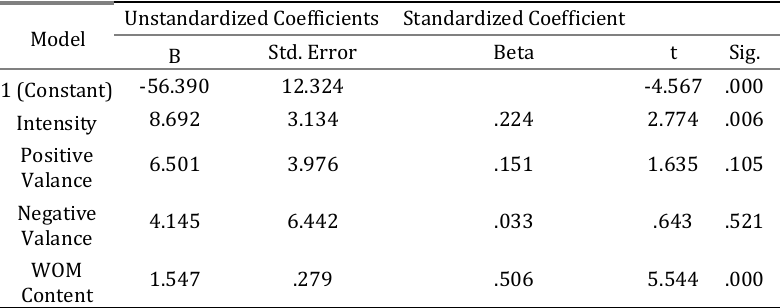
Table 1 Multiple regression equation